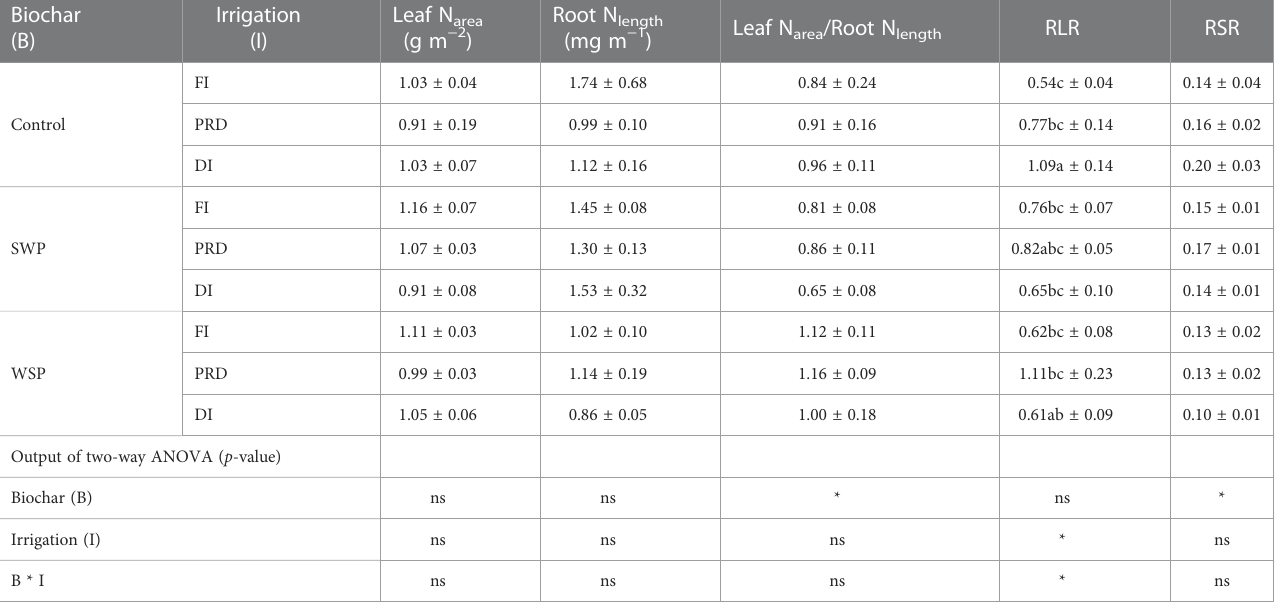
TABLE 7 The effects of treatments and output of two-way ANOVA for [N] leaf per unit leaf (leaf N area ), [N] root per unit root length (root N length ), leaf N area - to-root